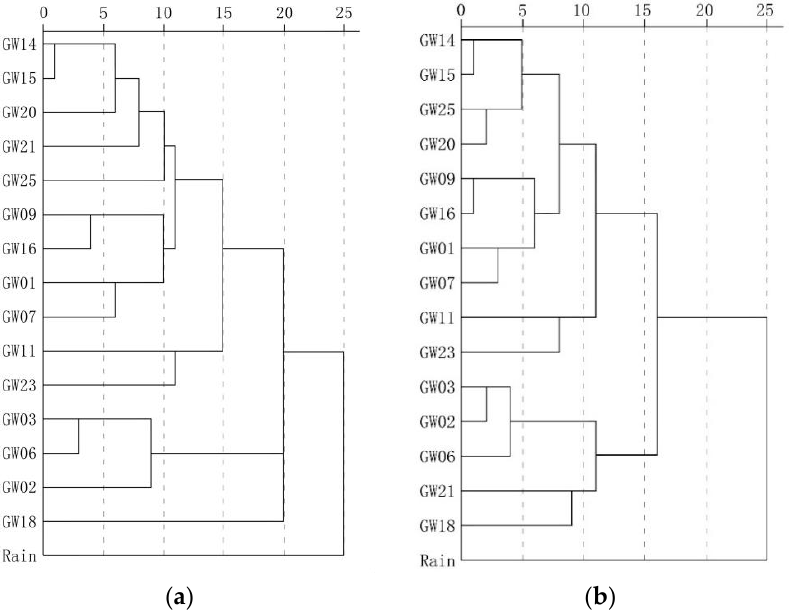
Figure 9. Comparison of the results of traditional clustering analysis and optimization clustering analysis. ( a ) Traditional fuzzy clustering analysis. ( b ) Optimized fuzzy clustering analysis.